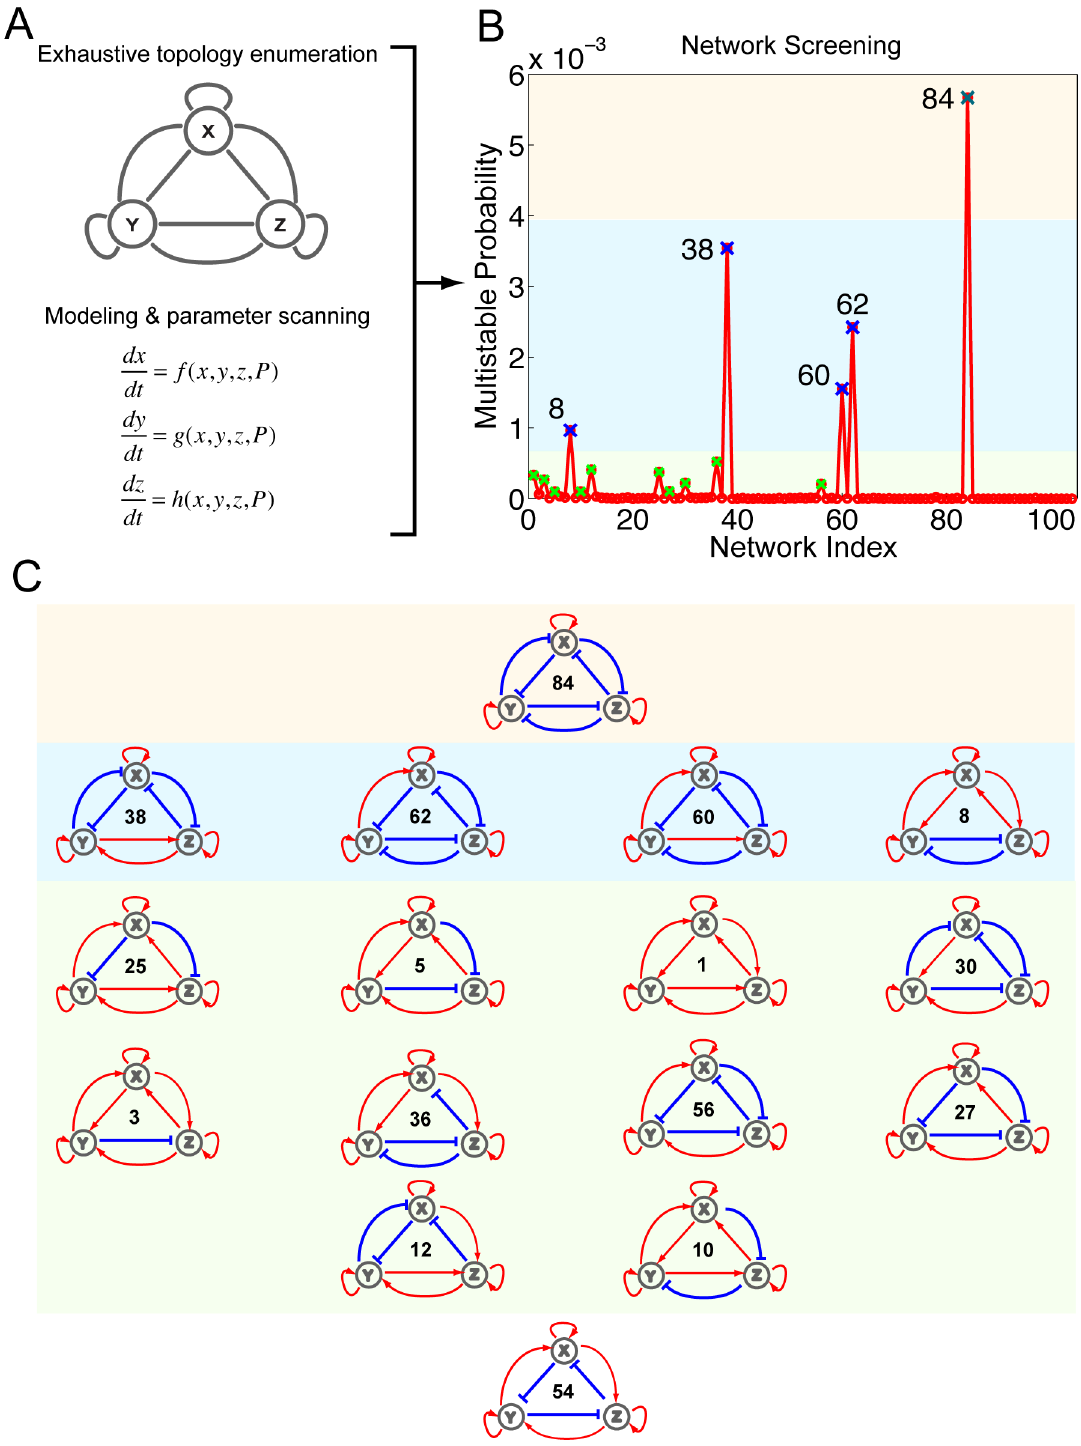
Figure 2. High-throughput computational screening for multistable networks. (A) FCTs were enumerated and modeled by ODEs (parameters denoted as P ). (B) The probability of multistability for each of the 104 FCTs generated by the computational screen is plotted. FCTs with a high probability of multistability are marked with an X with the color representing the multistability group; the two highest probability groups are labeled by their indices. Colored backgrounds serve as visual aids to distinguish the top three groups. (C) Fifteen FCTs with significant multistable potentials are listed with groups ranked according to their probability for multistability. The red arrows indicate activating regulation and blue T-head arrows indicate inhibitory regulation. Network 54 was included because it was the only network with complete auto-activation that did not have a high multistable potential.